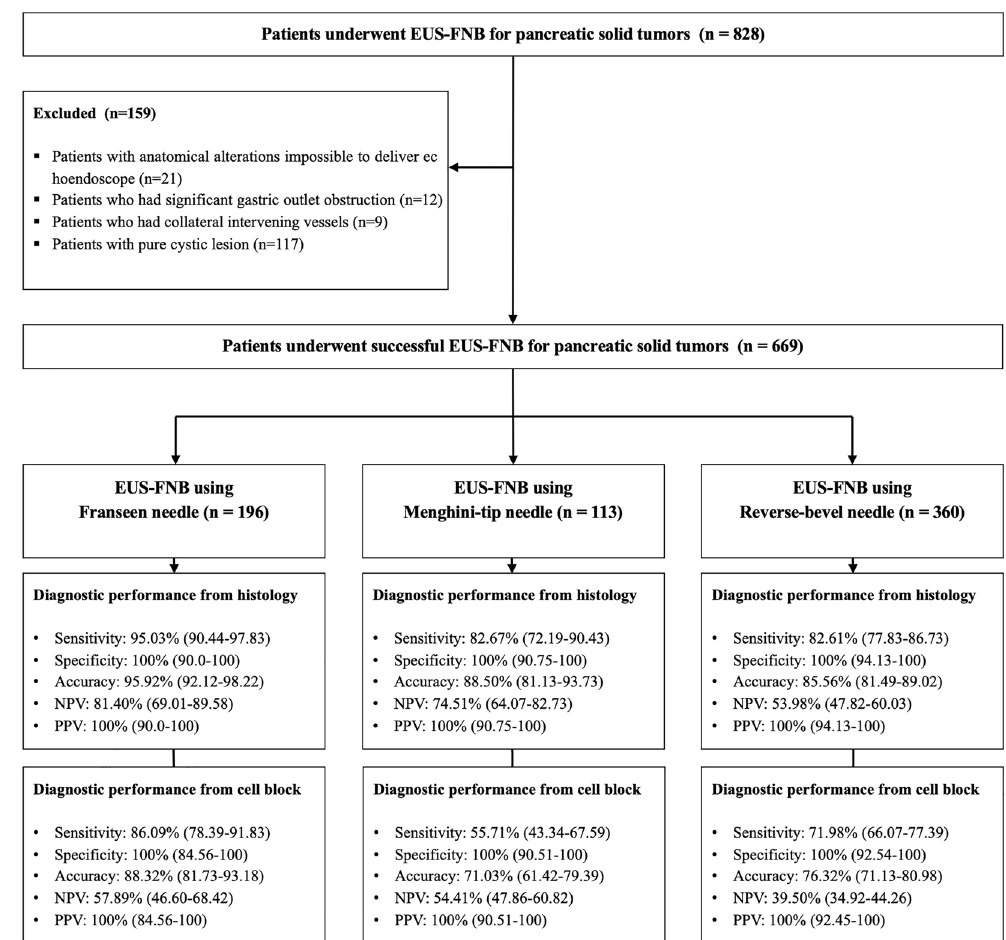
Figure 2. Flow diagram of patients throughout the